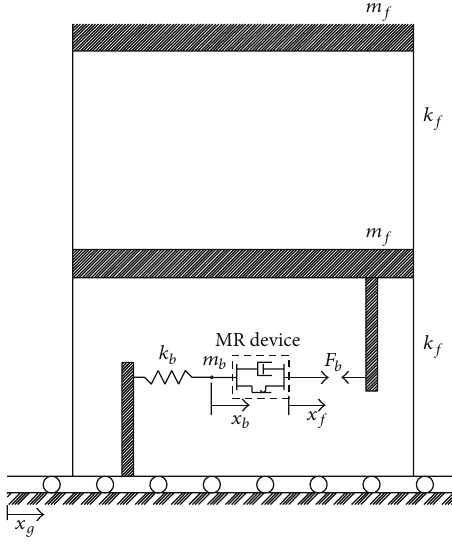
Figure 4: Model of the tested structure.